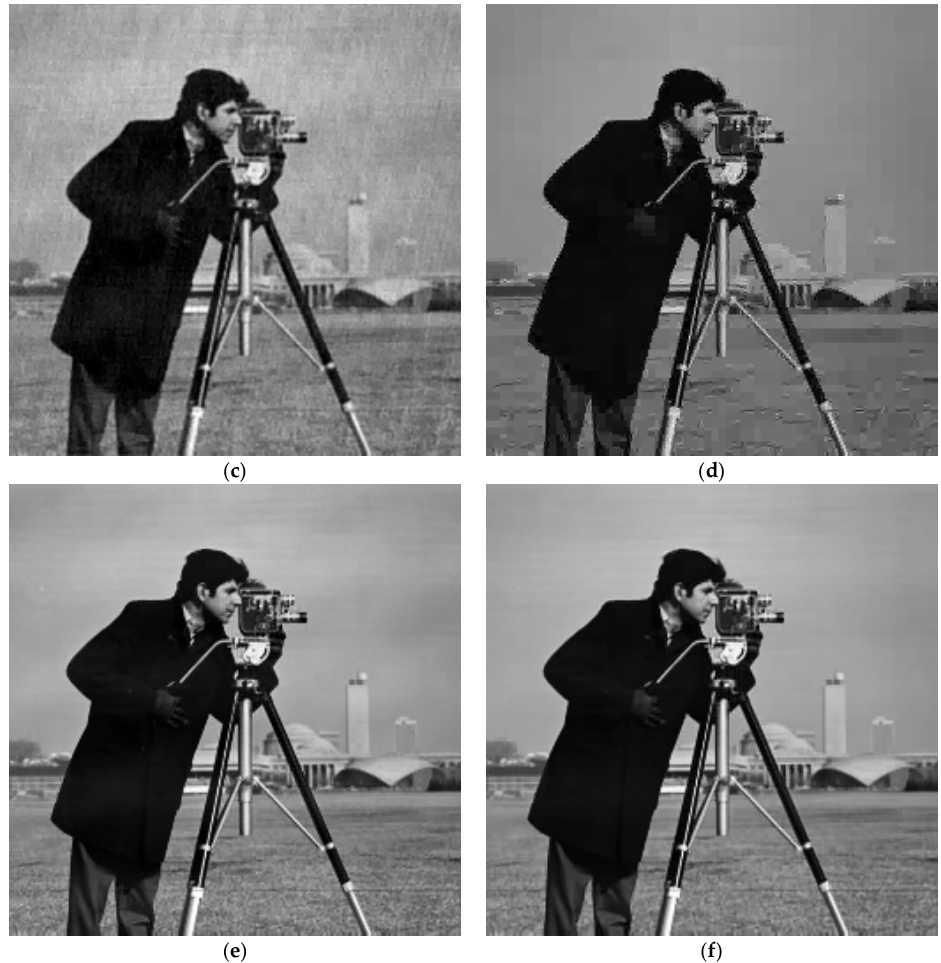
Figure 6. Visual quality comparison of image CS recovery using different algorithms for image “Cameraman” in the case of sample rate = 20%. ( a ) The original; ( b ) FCSA (PSNR = 25.92 dB, SSIM = 0.6784); ( c ) WaTMRI (PSNR = 27.07 dB, SSIM = 0.7451); ( d ) Turbo-AMP (PSNR = 27.48 dB, SSIM = 0.8523); ( e ) D-AMP (PSNR = 31.01 dB, SSIM = 0.9329); ( f ) PPP-CS (PSNR = 32.73 dB, SSIM = 0.9448).